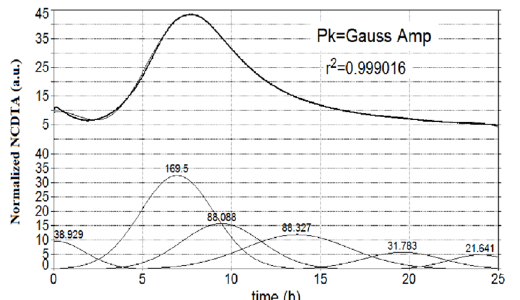
Figure 2. Deconvolution of reference sample.